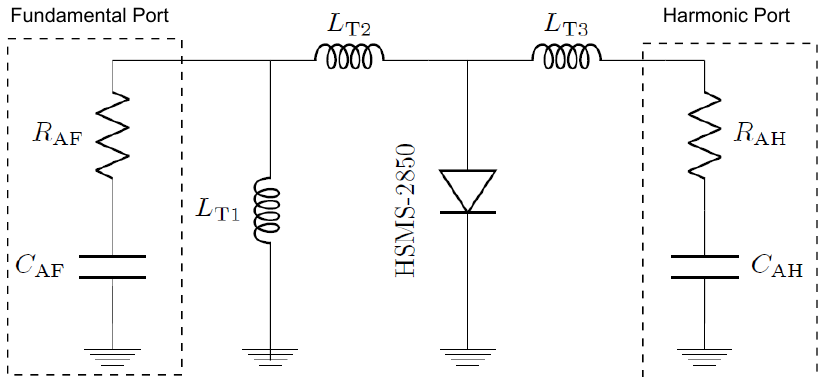
Figure 3. The transponder simplified single-ended circuit model.